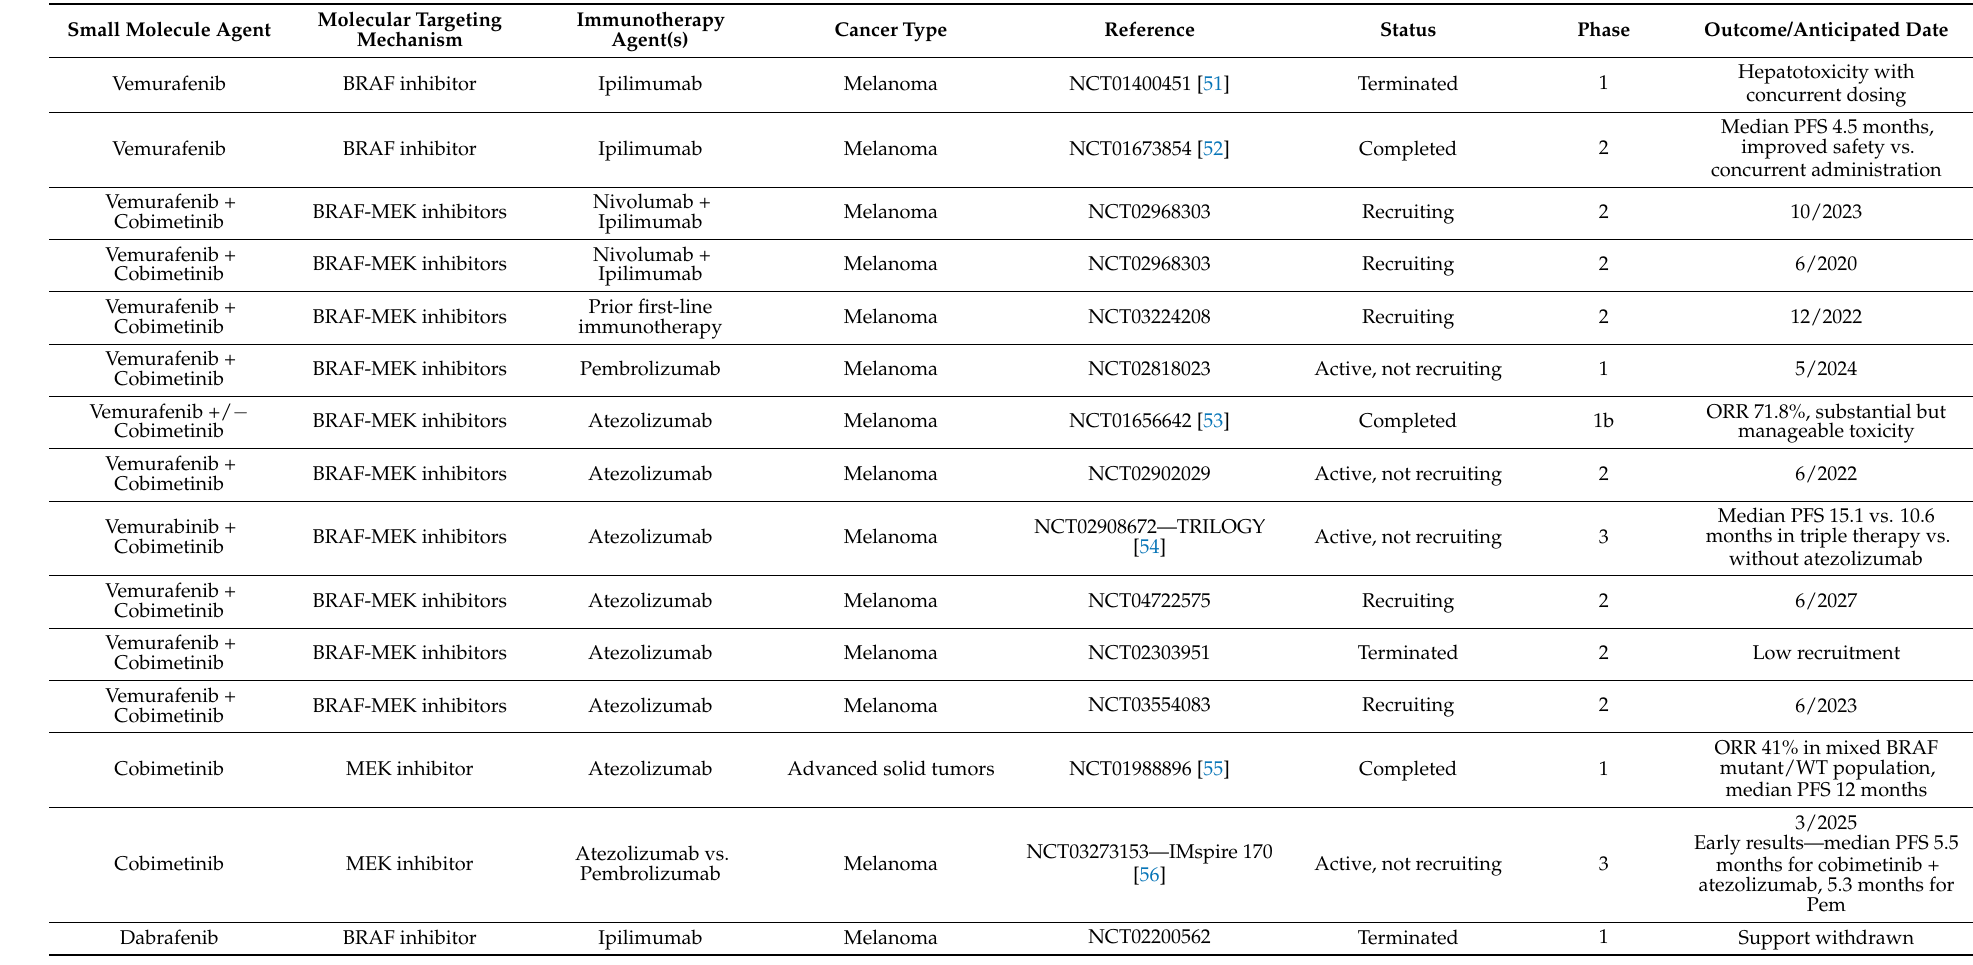
Table 1. Completed and ongoing clinical trials combining small molecules and checkpoint inhibitors in malignant